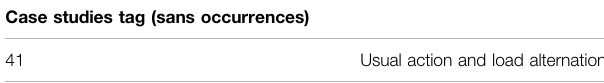
TABLE 4 | No occurrence case studies for MSU/ORNL